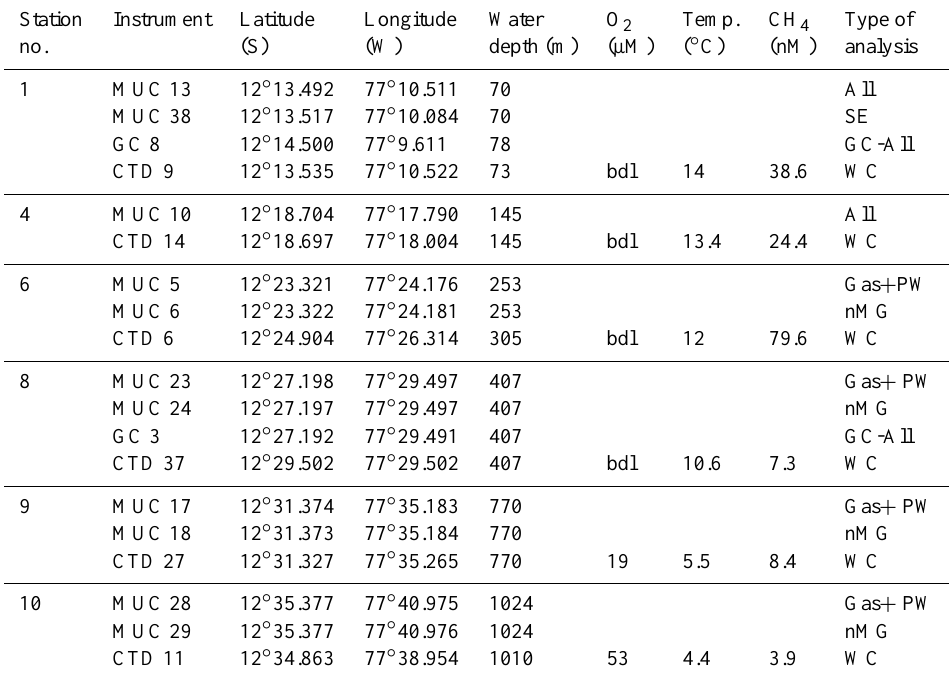
Table 1. Stations, instruments, chemical/physical parameters in the bottom-near water, and analyses applied to samples along the depth transect on the Peruvian margin (12 ◦ S). For abbreviations see footnote. Station Instrument Latitude Longitude Water O 2 Temp. Type of